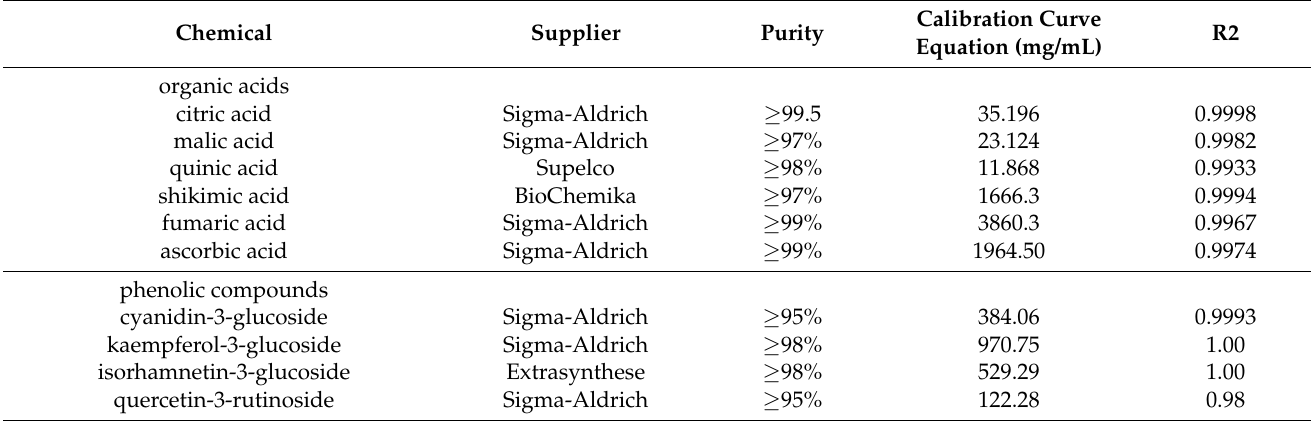
Table A1. Details of all chemical standards used (supplier and purity) and standards used for the calculation of contents in rose